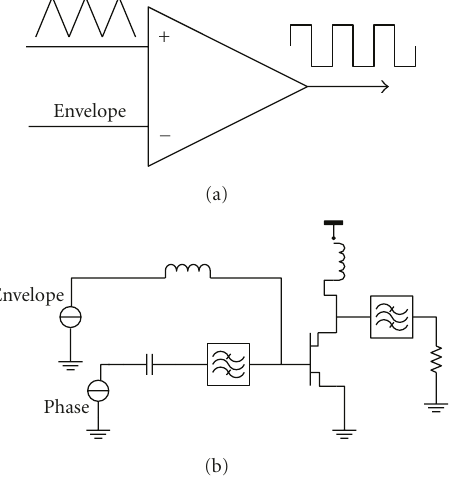
Figure 3: PWM generation: (a) ideal, (b) PA schematic.